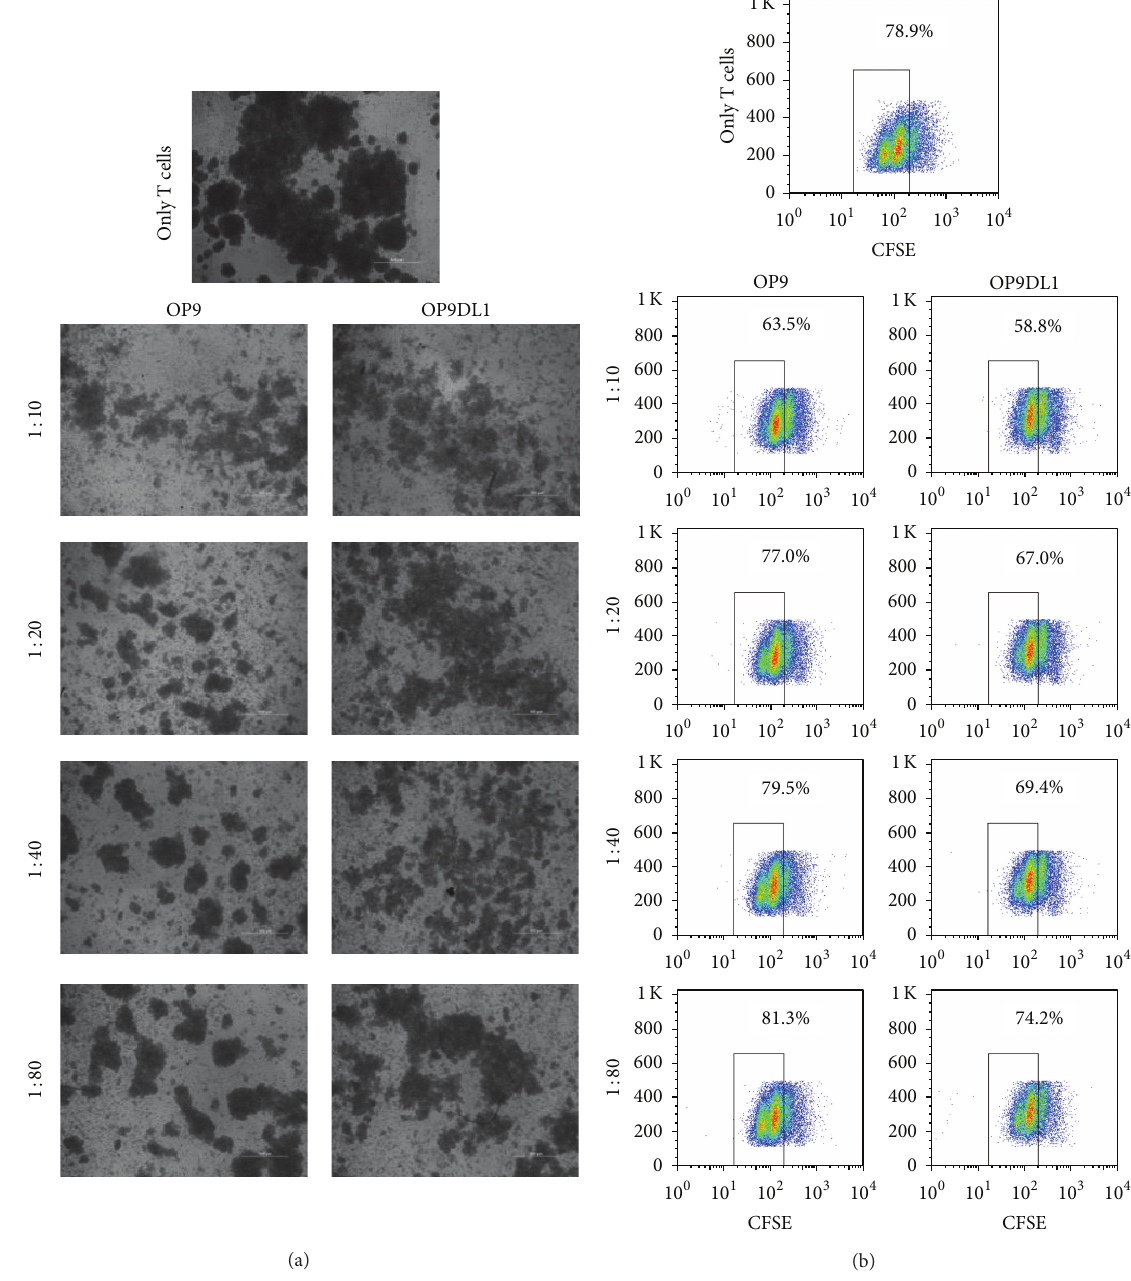
Figure 5: OP9 and OP9DL1 inhibit proliferation of mature T cells in vitro . CD3 + T cells were isolated from murine spleens with CD3 𝜀 MicroBead Kits and labeled with CFSE. T cells were stimulated with PMA (50ng/mL) plus ionomycin (1 𝜇 g/mL) for 24 h and then cultured alone or with OP9 or OP9DL1 at different ratios (OP9 or OP9DL1 cells to T cells). After 36 h, all of the cells were analyzed via microscope (a) and flow cytometry (b) for T cell proliferation as indicated by the reduction in CFSE intensity. Data are representative of three independent